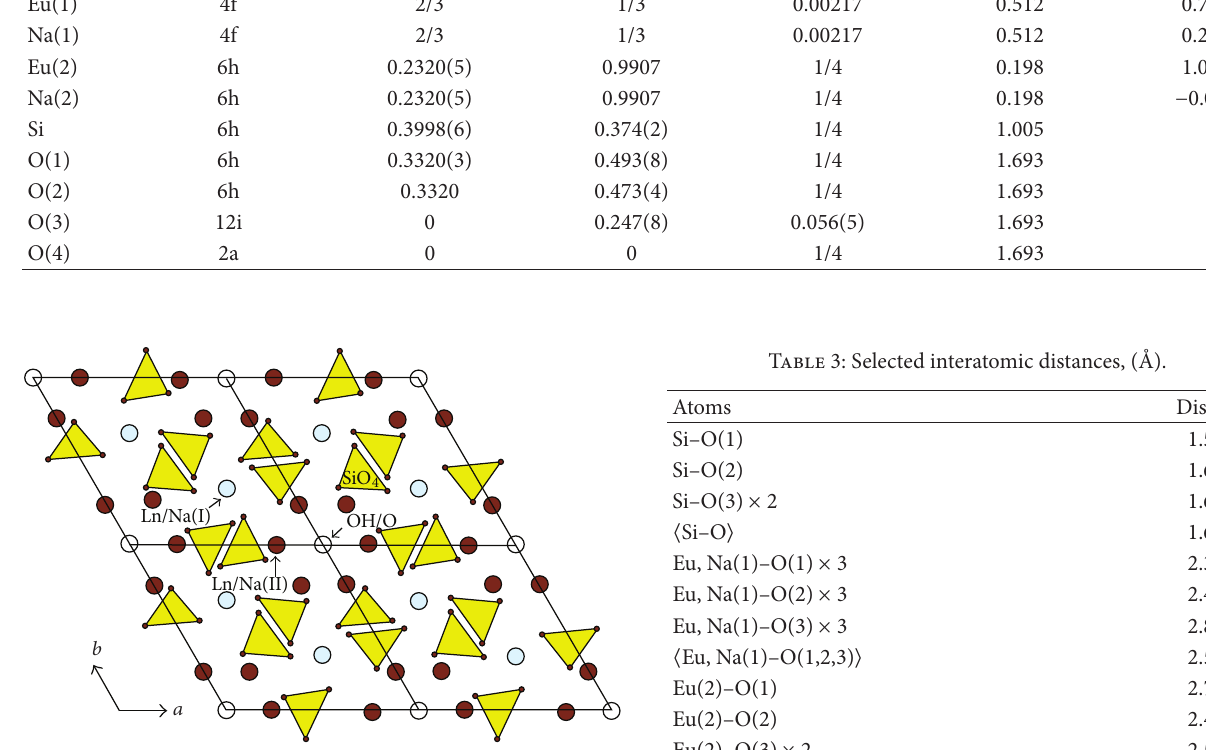
F 4: �iew of the re�ned crystal structure of the apatites